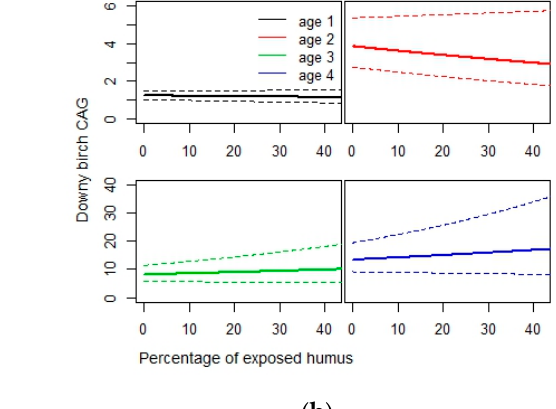
proportion of exposed mineral soil at the mean level of 20% exposed mineral soil. Note the different effect of